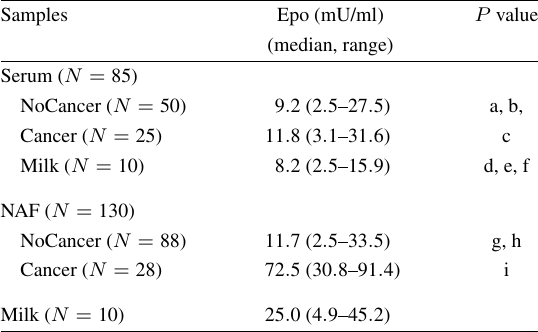
Erythropoietin levels in nipple aspirate fluid and sera based on the cancer presence